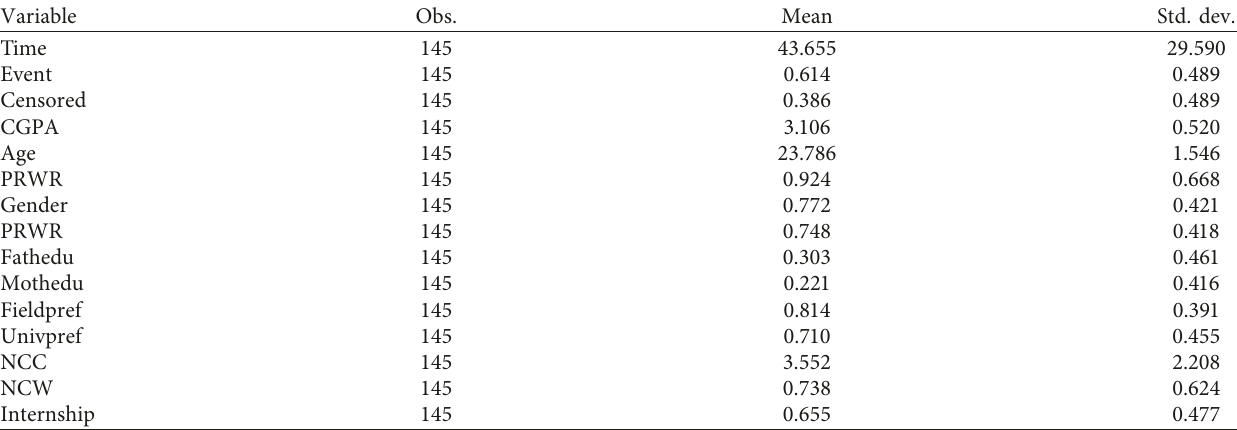
Table 1: Summary of descriptive statistics.